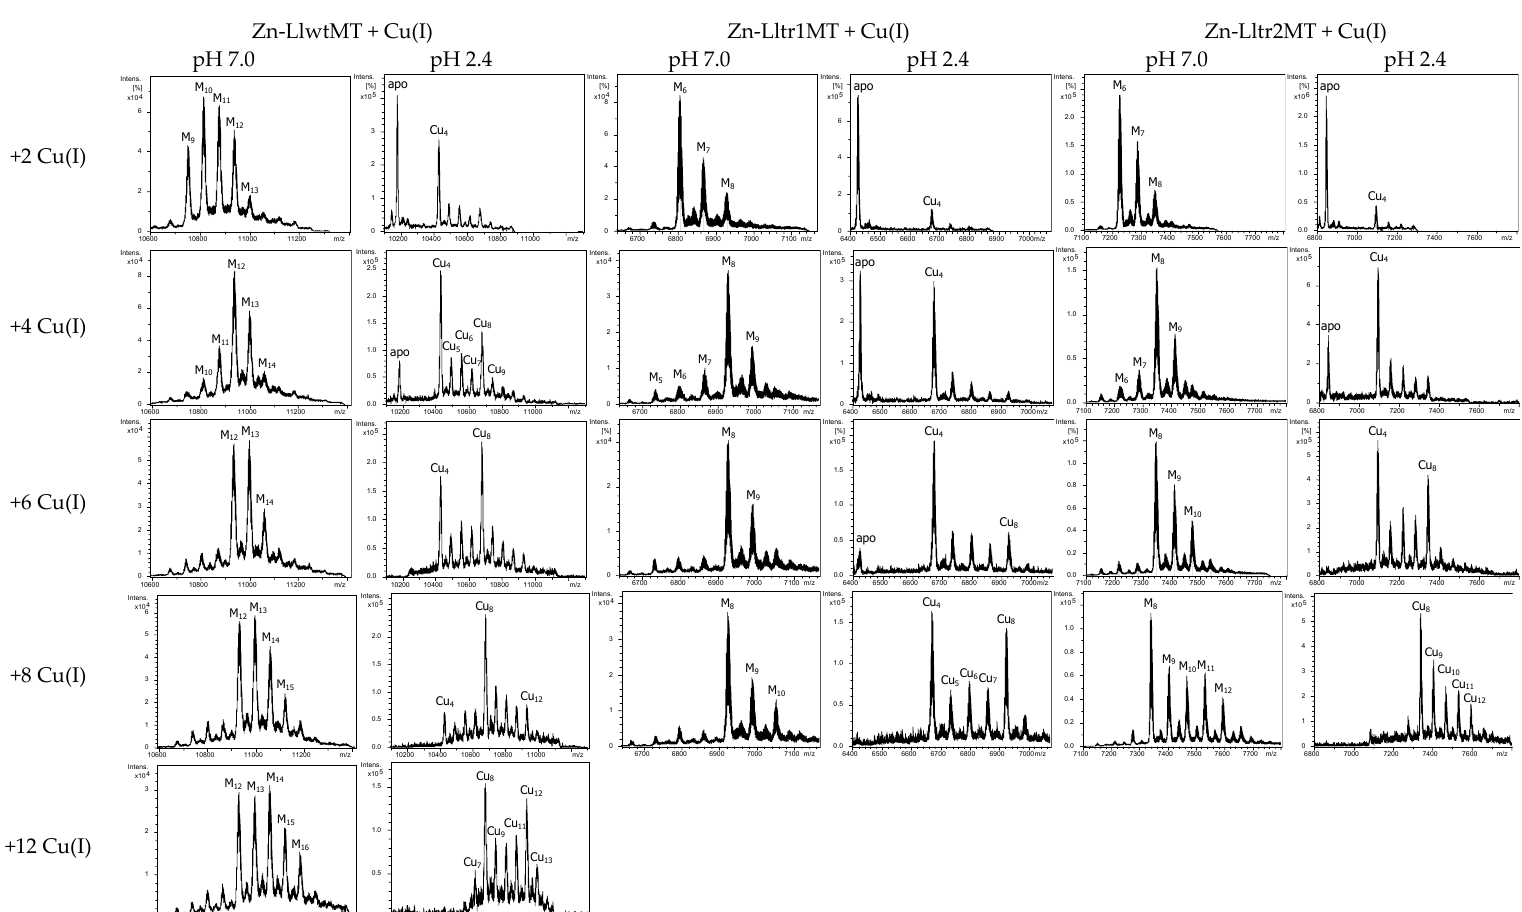
Figure 8. Zn(II)->Cu(I) replacement reaction on the Zn 9 -LlwtMT, Zn 6 -Lltr1MT, and Zn 6 -Lltr2MT complexes. Deconvoluted ESI-MS recorded, at pH 7.0 and 2.4, after the addition of 2, 4, 6, 8, and 12 equivalents of Cu(I) to the recombinant Zn-LlMT preparations.